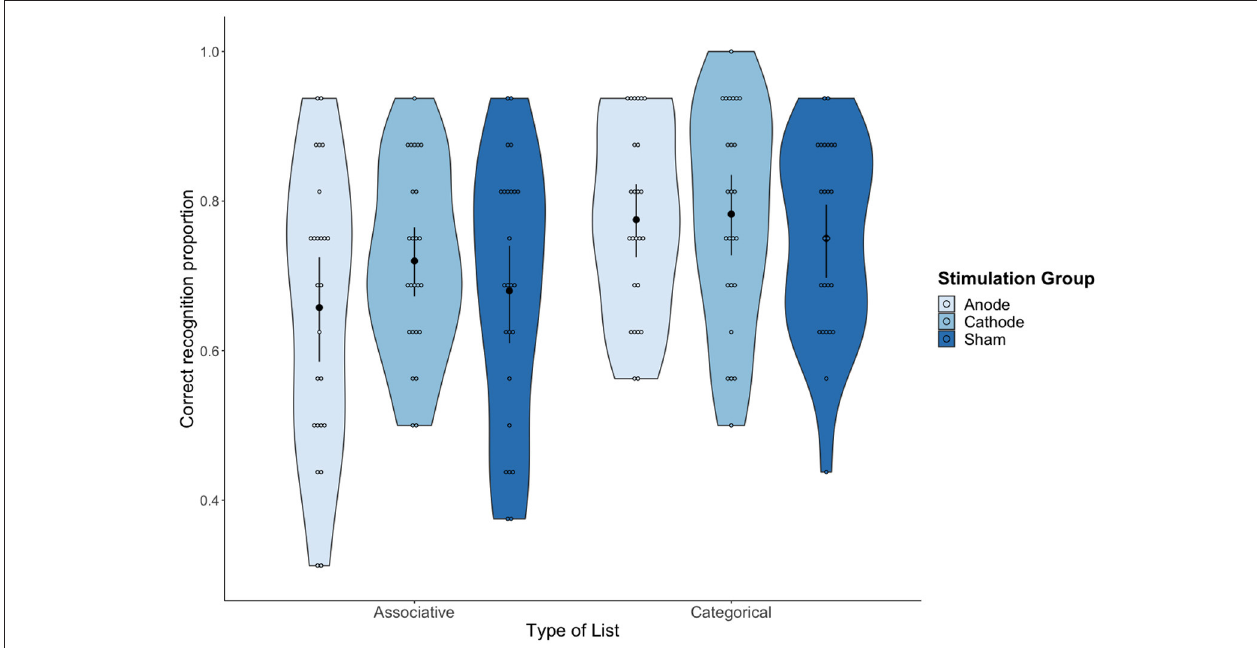
FIGURE 2 | Mean proportion of correct recognition as a function of tDCS condition and Type of list. Error bars represent 95% confidence intervals (CIs).